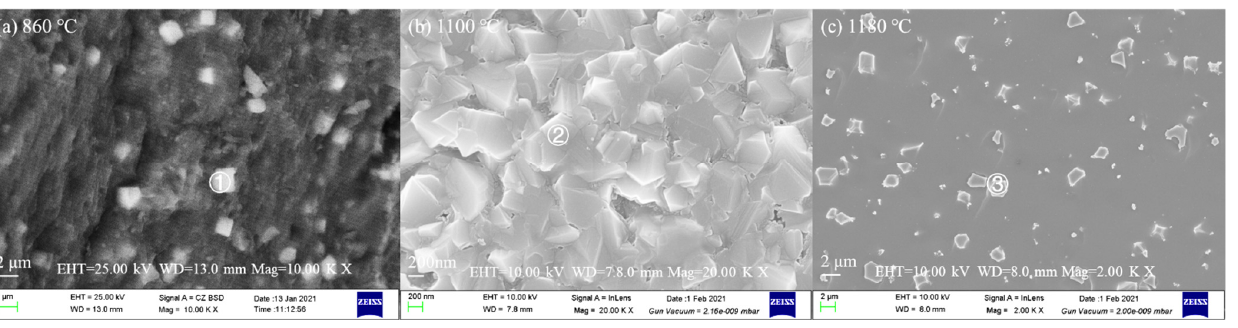
Figure 6. Microstructure of the olivine basalt glass after crystallization at different temperatures. Table 5. Atomic compositions of the olivine basalt glass crystalline phase.